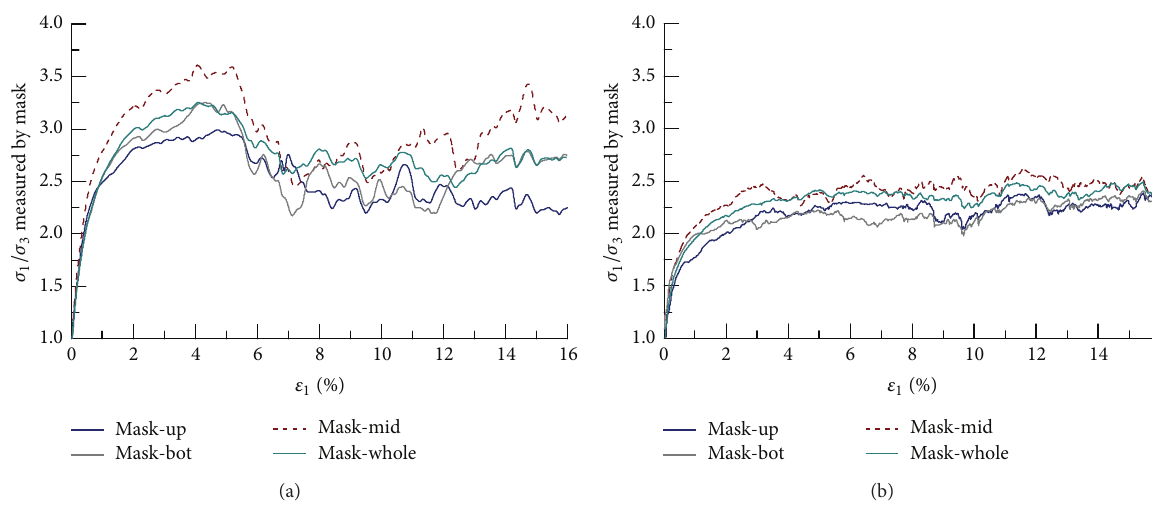
Figure 15: The evolution of stress ratio 𝜎 1 /𝜎 3 measured in different masks with axial strain 𝜀 1 under Rigid boundary B: (a) 𝛿 = 0 ∘ and (b) 𝛿 = 90 ∘ .